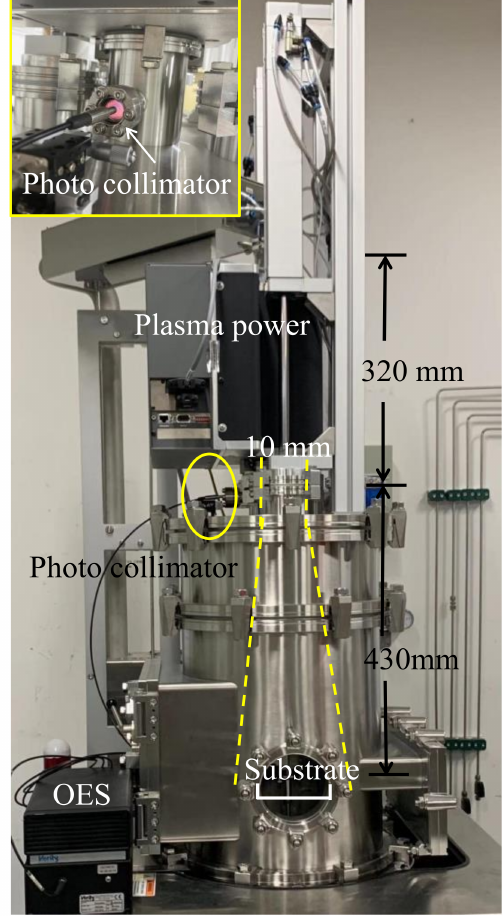
Figure 1. Outline image of the ALD system and visual observation of the glow discharge at 2000 W.